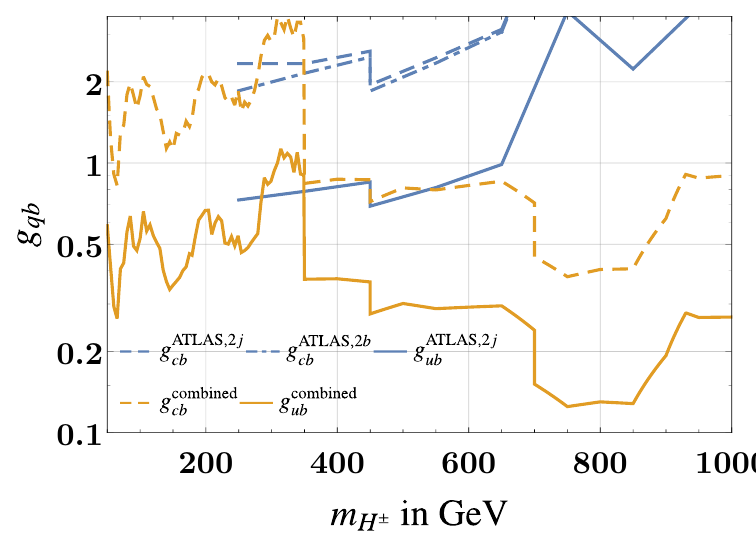
Figure 6 . Upper limits at 95% CL on the couplings g ub (solid) and g cb (dashed) as a function of the charged-Higgs mass m from recasting Z 0 -searches with ISR photons in ref. [62] (blue) and H ± ISR jets refs. [60, 61, 63, 64] (orange). See text for